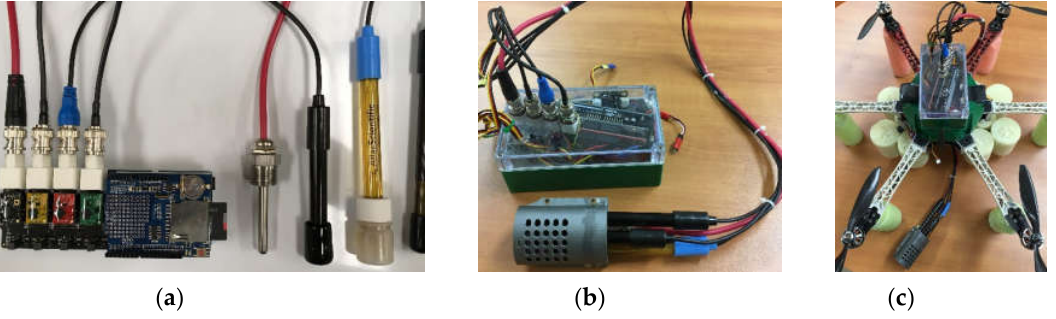
Figure 3. ( a ) The open-source multiprobe meter (OSMM) components; ( b ) placed in a waterproof case; ( c ) placed on top of the unmanned aerial vehicle (UAV).